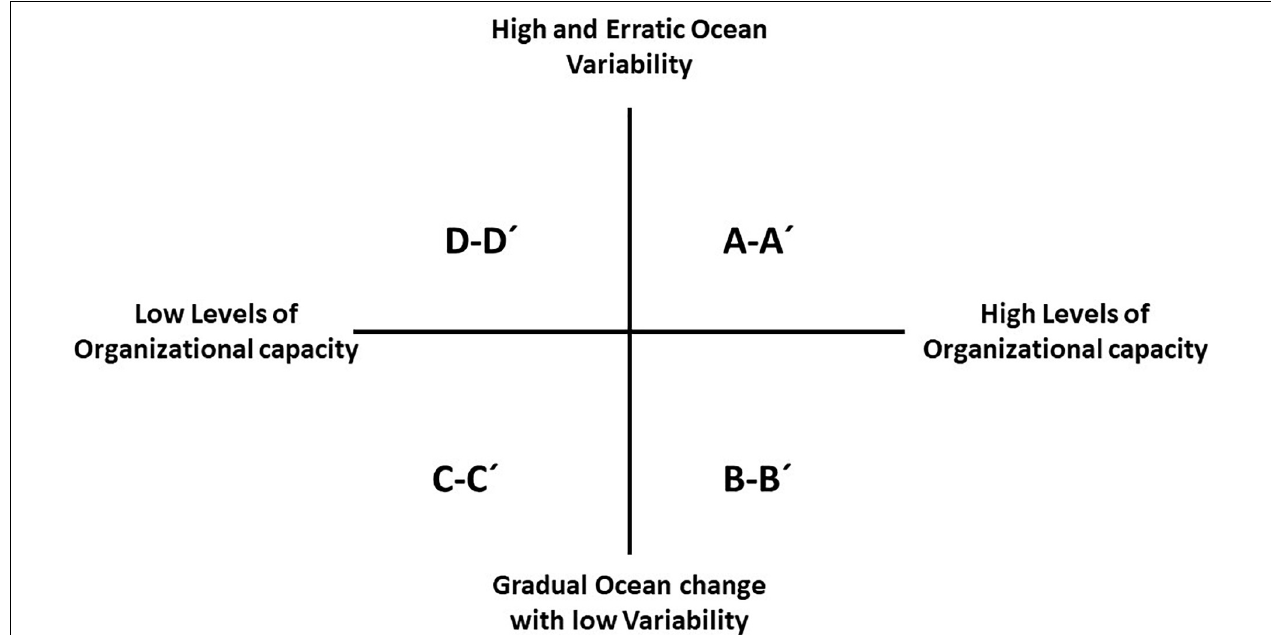
FIGURE 3 | Drivers of the axis limiting the quadrants in which each pair of groups (A-A (cid:48) ,B-B (cid:48) ,C-C (cid:48) ,D-D (cid:48) ) of the central workshop elaborated the narratives ( cf . section “Developing the Scenarios: A Participatory Stakeholder Workshop”).